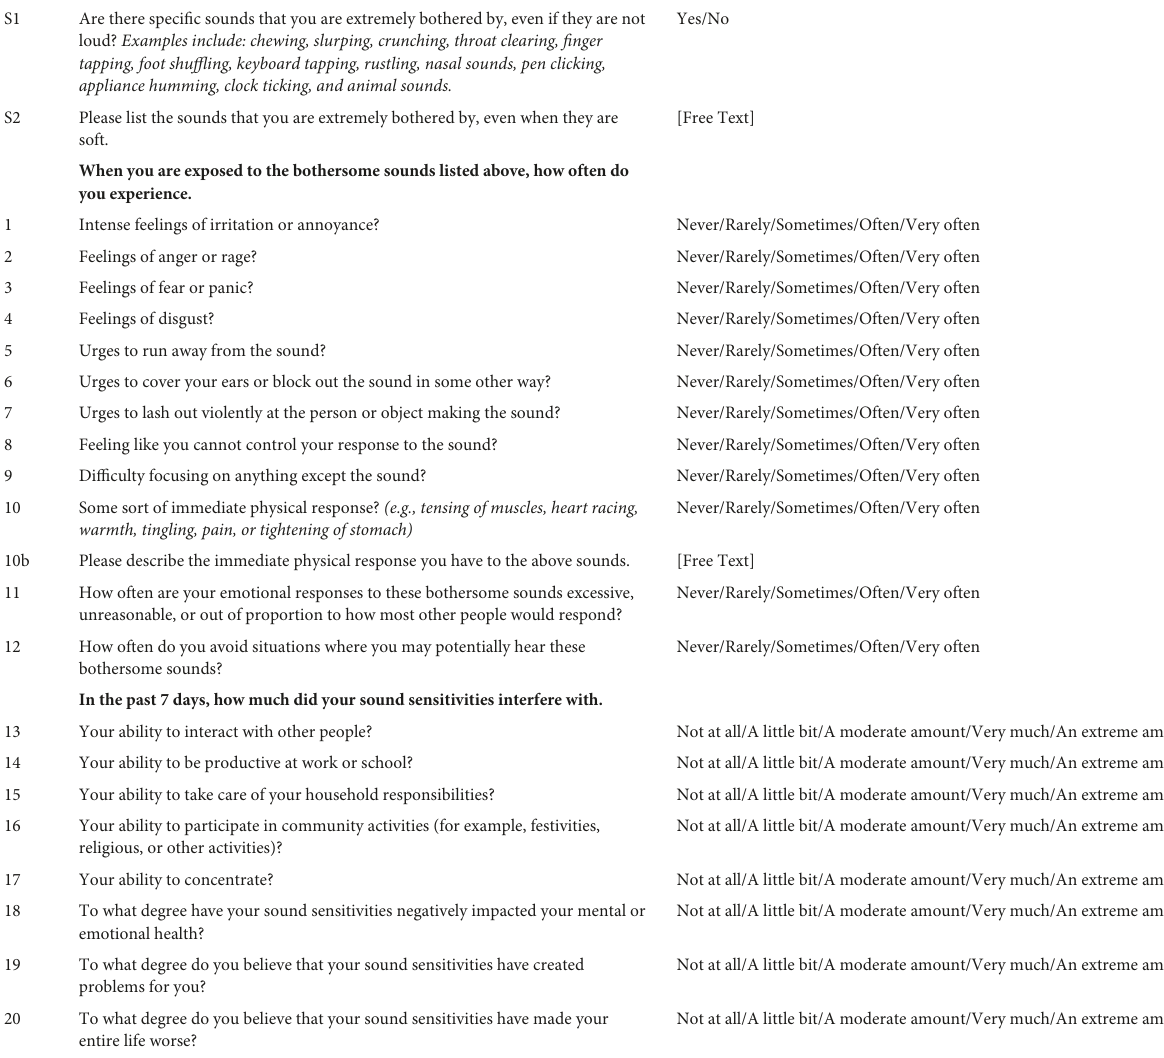
TABLE 1 Original DVMSQ items, content, and response